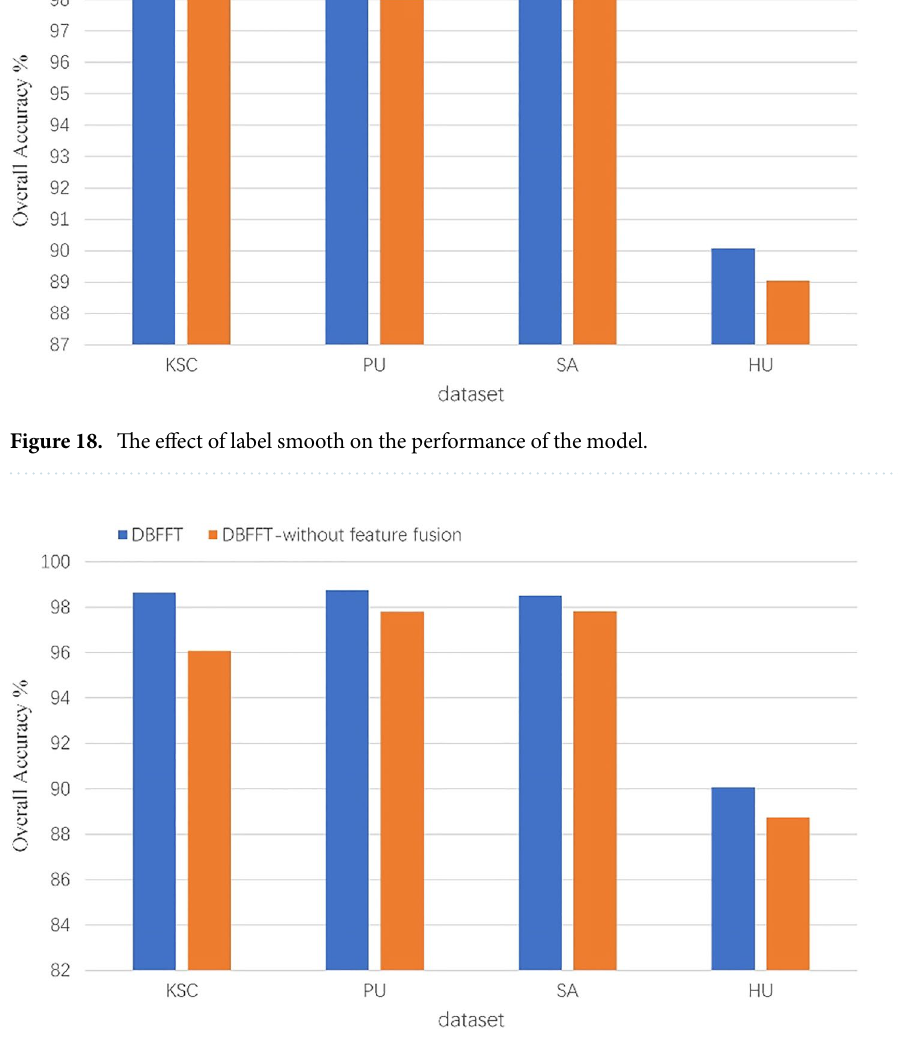
Figure 19. The effect of feature fusion on the performance of the